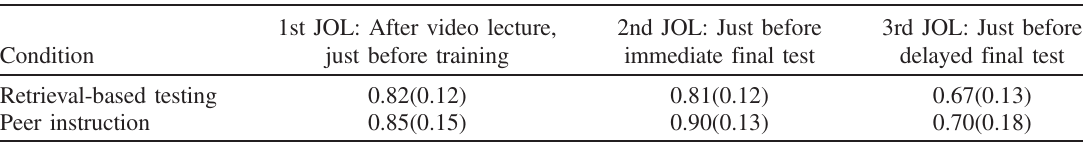
TABLE III. Mean and S.D. values for JOL made at all three time points for both